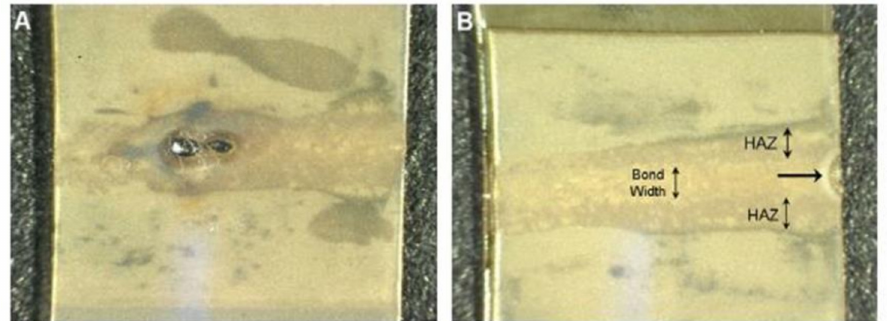
Figure 21. ( A ) Heat damage for the amorphous sample with power 20 W and speed 4 mm/s ( B ) Damage at the joint edge of the sample. Reproduced with permission from Ref. [10]. Copyright (2010), Materials and